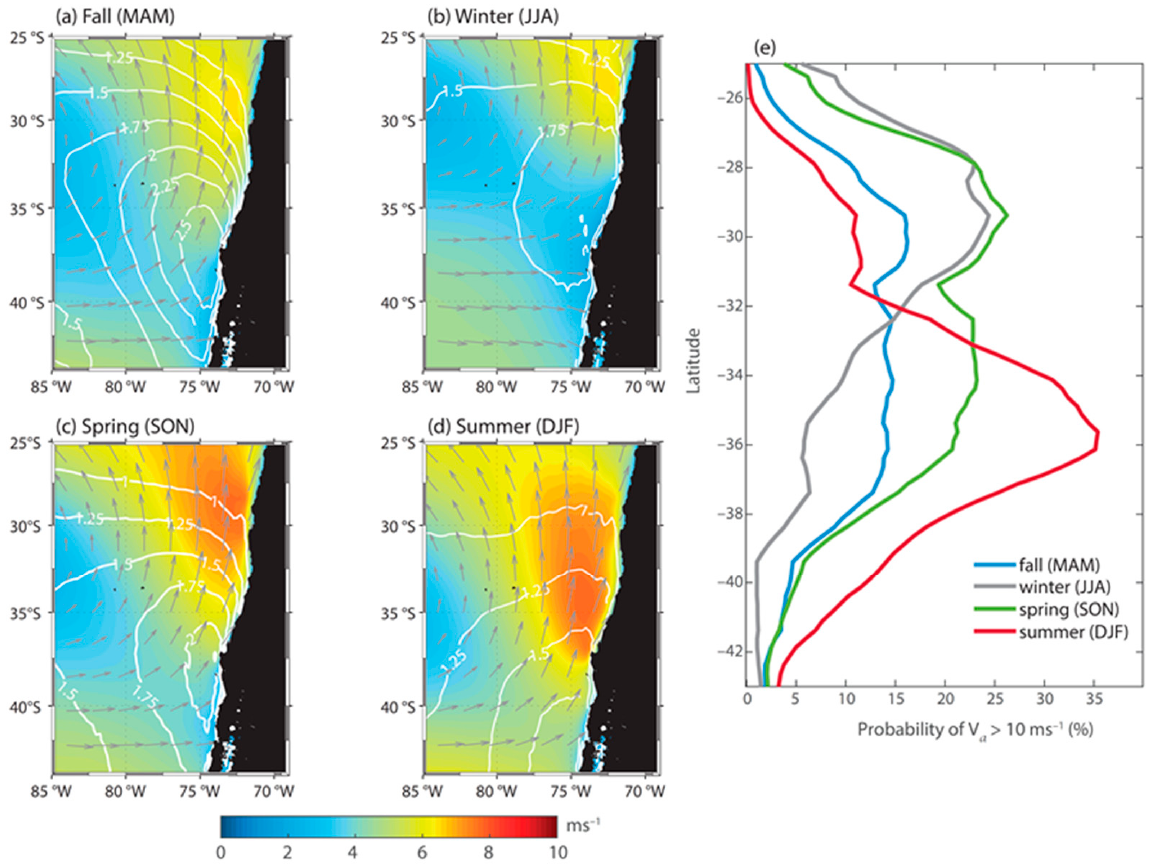
Figure 6. Climatology of the wind speed (colors, ms − 1 ), wind direction (vectors) and the standard deviation of the V a (contours) from ERA5 reanalysis (1979–2019) in the study area. ( a ) Fall (March–April–May), ( b ) winter (June–July–August), ( c ) spring (September–October–November) and ( d ) summer (December–January–February). ( e ) Percentile for a value of 10 ms − 1 in the V a distribution at each season.